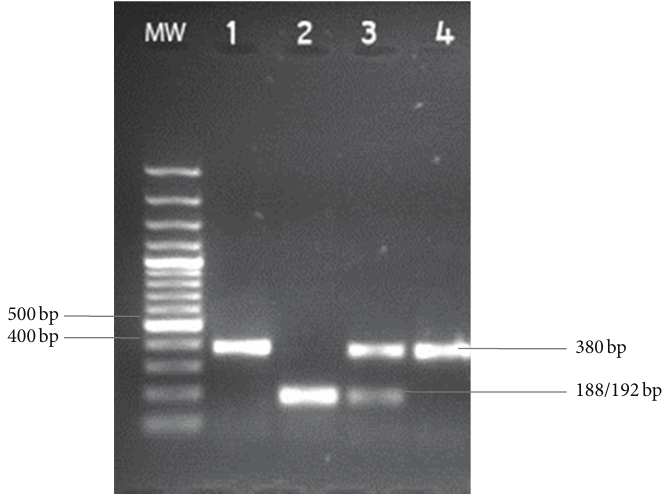
Figure 3: RFLP of HBB fragment with DdeI. Lane 1: undigested control, Lane 2: HbAA control, Lane 3: HbAS control, and Lane 4: HbSS MW: molecular weight